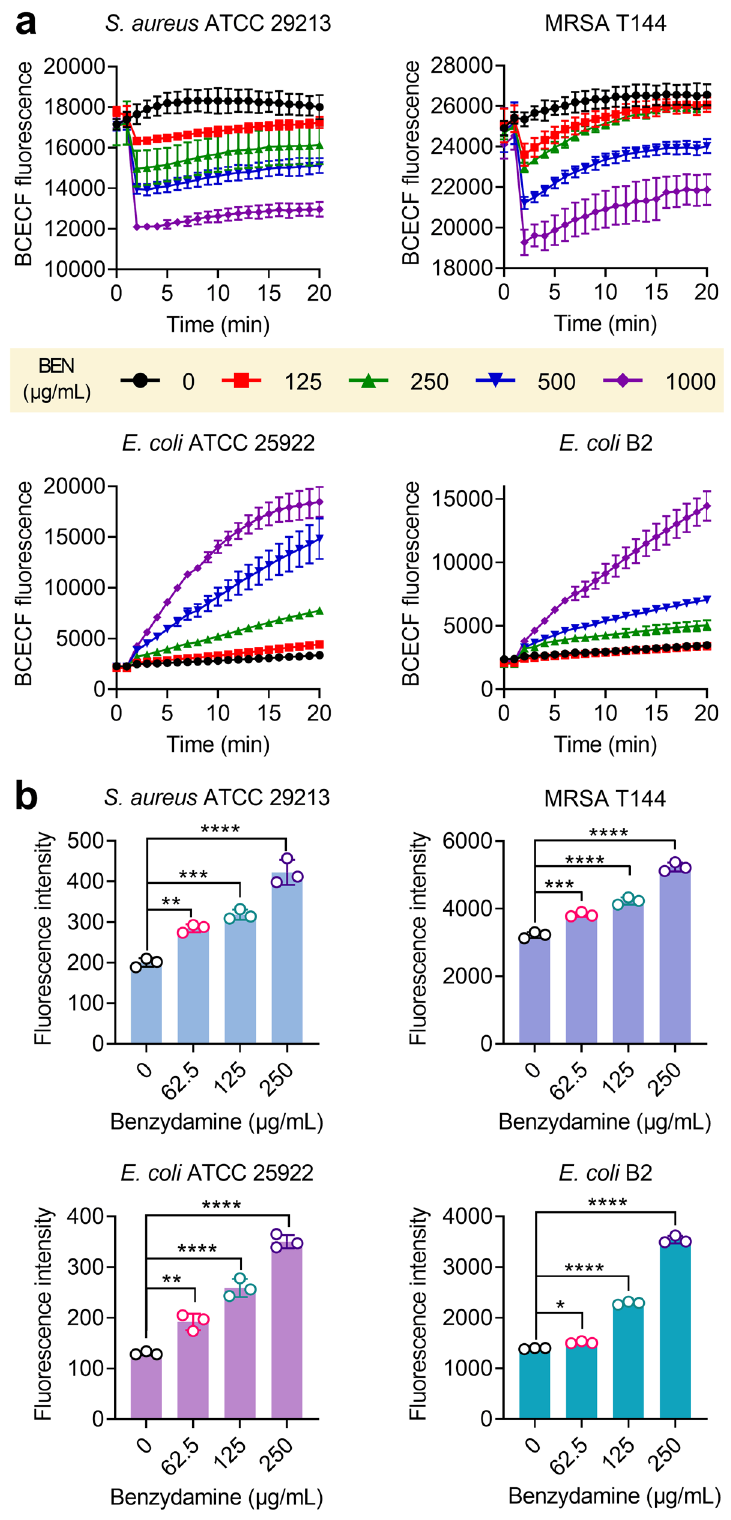
Fig. 3 Benzydamine upregulates ▵ pH and promotes the intracellular accumulation of doxycycline. a Upregulation of ▵ pH in BCECF-AM-labeled bacterial cells after exposure to varying concentrations of benzydamine. In Gram-positive bacteria, benzydamine decreases fl uorescence and the cytoplasmic pH. In contrast, benzydamine increases fl uorescence and the cytoplasmic pH in Gram-negative bacteria ( E. coli ATCC 25922 and E. coli B2). b Benzydamine supplementation dose-dependently promotes the intracellular accumulation of doxycycline in bacteria. Intracellular antibiotic content was determined by monitoring the fl uorescence of doxycycline (excitation wavelength, 405 nm; emission wavelength, 535 nm). All data from three biological replicates were presented as mean ± SD, and the signi fi cance was determined by non-parametric one-way ANOVA (* P < 0.05, ** P < 0.01, *** P < 0.001, **** P < 0.0001).